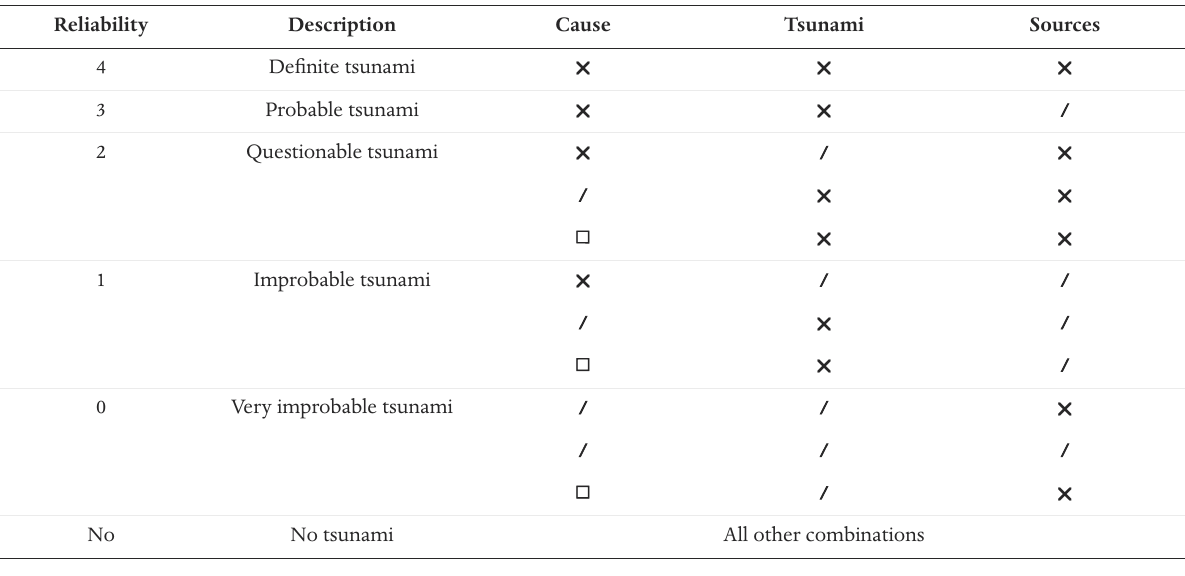
Table 2. Reliability Scale used in the EMTC (from Tinti et al. [2004]). r : fulfilled condition; / :partially fulfilled condition; □ : not fulfilled condition.